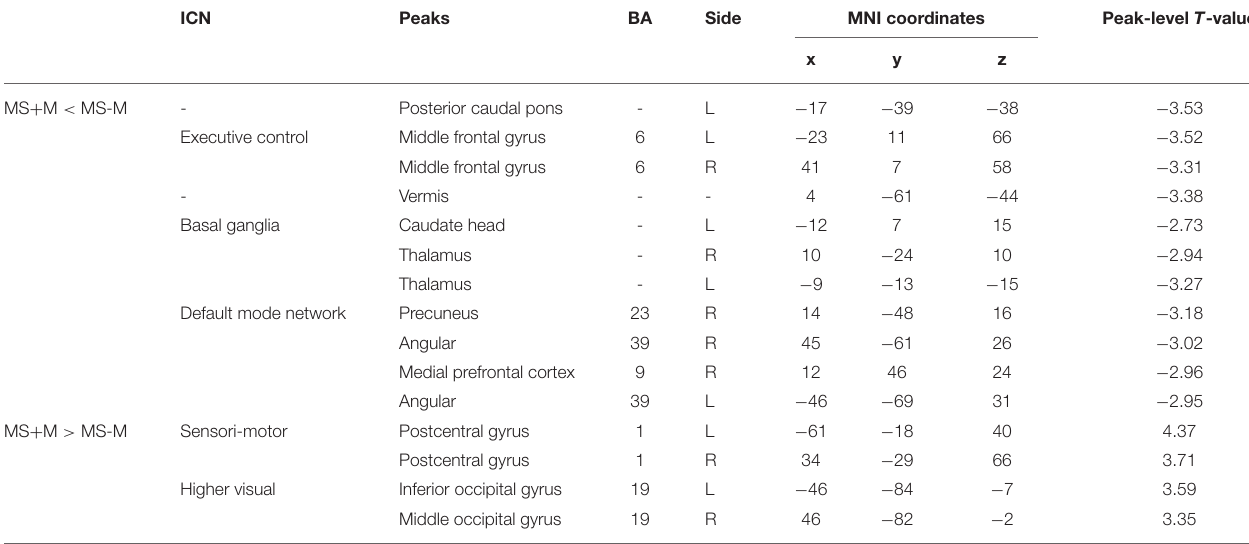
TABLE 2 | Differences between MS + M and MS-M patients in the PAG connectivity organization. ICN Peaks BA Side MNI coordinates Peak-level T -value